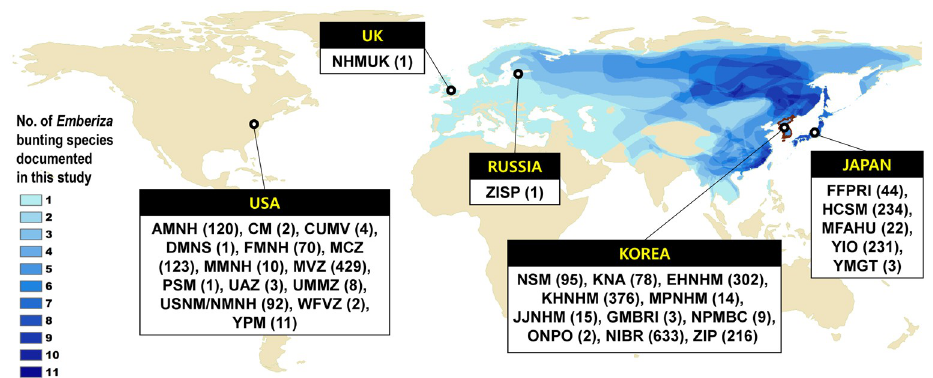
Fig 1. Overlapped distribution ranges of 17 Emberiza species recorded in Korea and used in this study. Overlapped distribution ranges are marked in blue contours. The museums and institutions that have preserved Emberiza bunting specimens collected in Korea since 1910 were abbreviated and have been marked on the countries in which they operate. The number of specimens used in this study were noted in parentheses. The base map was made with Natural Earth, and the distribution ranges were from the IUCN Red List for birds prepared by BirdLife International.